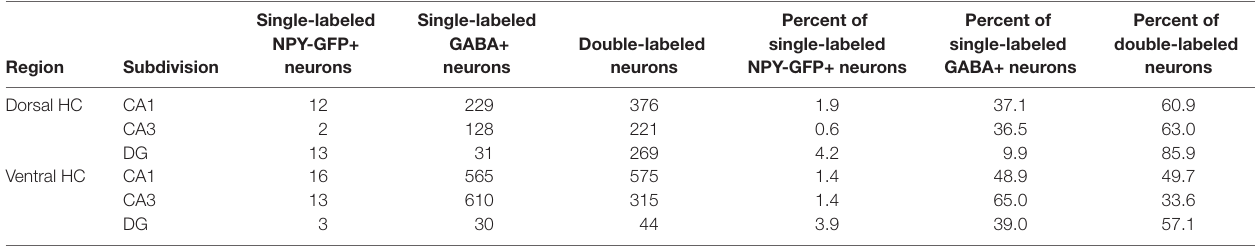
TABLE 2 | Co-localization of NPY-GFP and GABA in the hippocampus. Single-labeled Single-labeled Percent of Percent of Percent of NPY-GFP+ GABA+ Double-labeled single-labeled single-labeled double-labeled Region Subdivision neurons neurons neurons NPY-GFP+ neurons GABA+ neurons neurons Dorsal